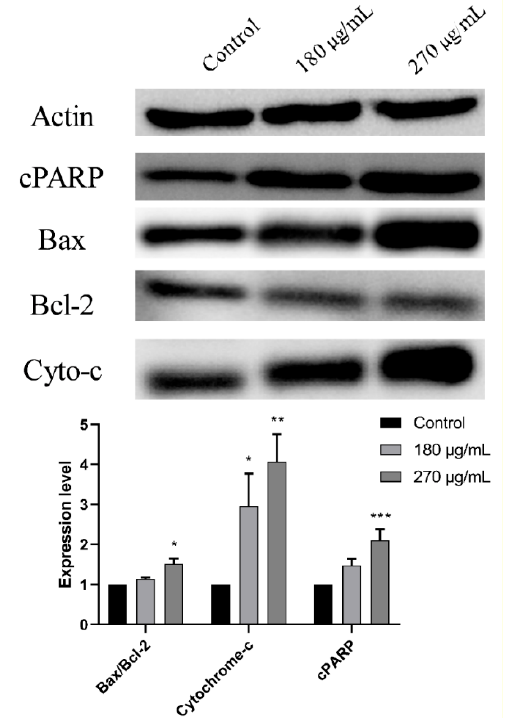
Figure 5. Western blot analysis and quantification of expression levels of apoptosis-regulating proteins in Monomac-1 cells treated with MMLE for 24 h. Significant upregulation of pro-apoptotic proteins such as cleaved poly(ADP-ribose) polymerase (PARP), Bax, and cytochrome-c and downregulation of anti-apoptotic proteins such as Bcl-2 were observed upon treatment of Monomac-1 cells with 180 µg/mL and 270 µg/mL. Significance relative to the control was reported with * indicating a p -value: 0.01 < p < 0.05, ** indicating a p -value: 0.001 < p < 0.01, and *** indicating a p -value: 0.0001 < p < 0.001. Detailed information of western blot can be found at Figure